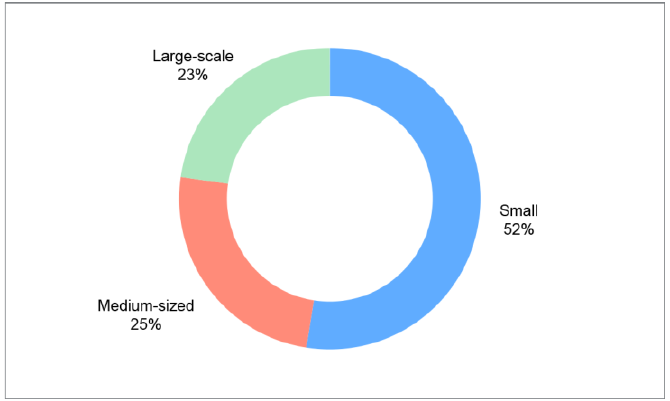
Figure 7. I4.0 potentials according to company size. Source: FINA (author ’ s work). However, although the number of companies with the potential for I4.0 is not large, they account for approximately 27% of assets of the non-probabilistic sample (approxi- mately 24% of the population of analyzed activities) and approximately 26% of the operat- ing income (22% of the population of analyzed activities), as displayed in Table 4. Table 4. Industry 4.0 potentials.